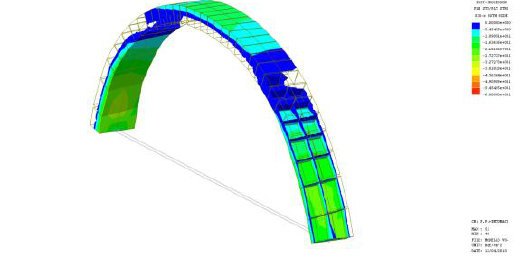
Figure 22a. Especially of arch before